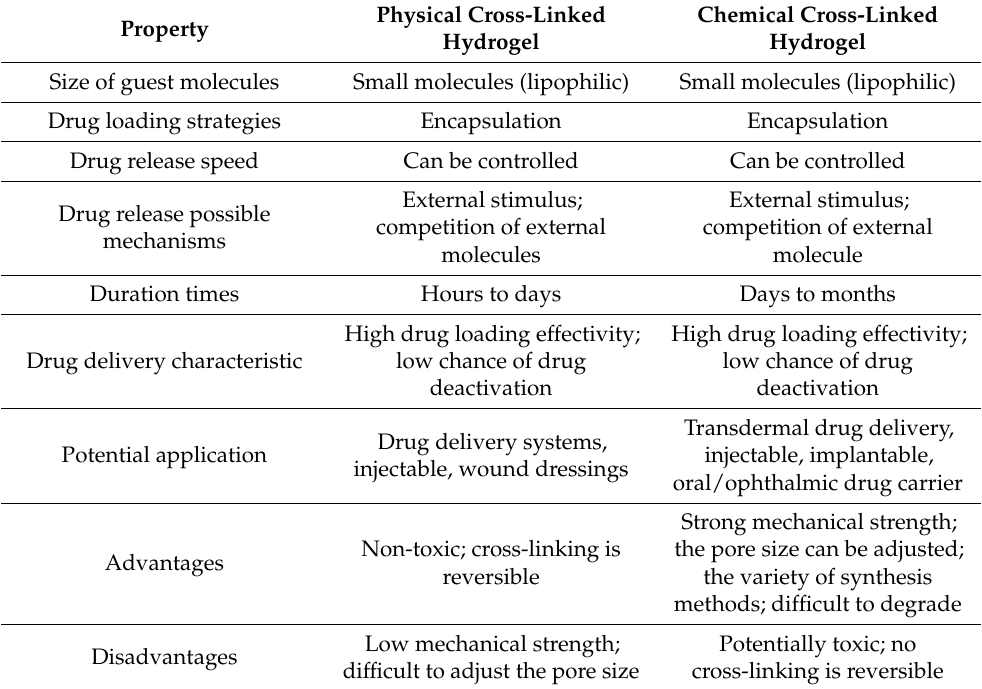
Advantages Disadvantages